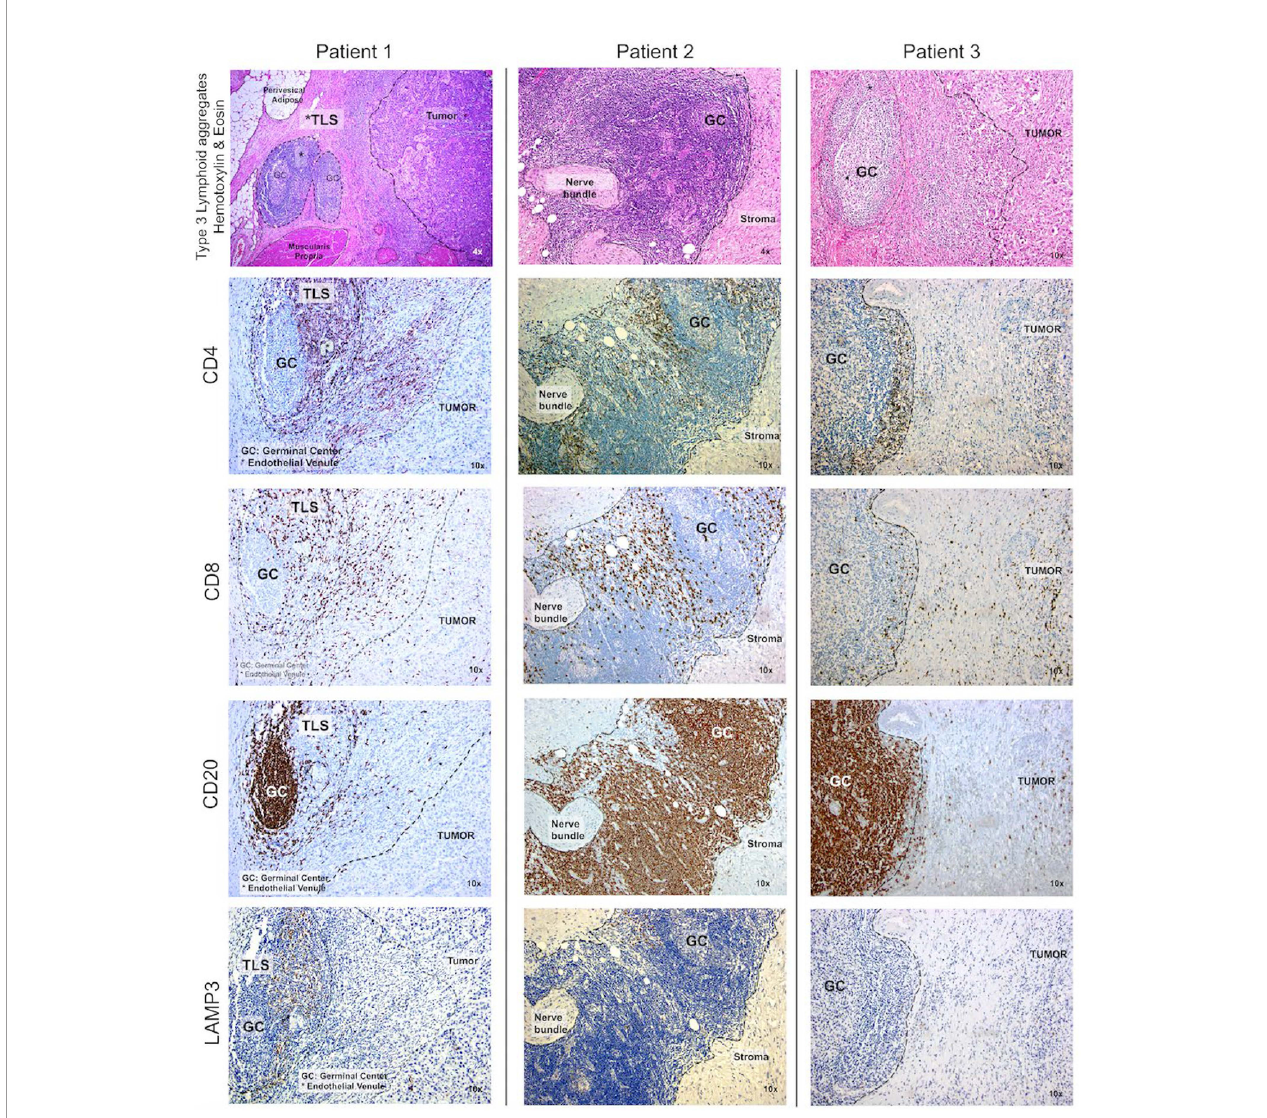
FIGURE 4 | High 12-chemokine scores correlated with higher densities of tumor in fi ltrating immune cells. Immunohistochemistry was performed using antibodies to CD4, CD8, CD20, and LAMP3 to mark CD4+ T cells, CD8+ T cells, B cells, and activated dendritic cells, respectively. Compared to samples with low 12-CK scores, the 12-CK high tumors were found to contain Type 3 TLS with prominent germinal centers, along with increased in fi ltrating CD4+ T cells, CD8+ T cells, CD20+ B cells, and comparable levels of activated dendritic